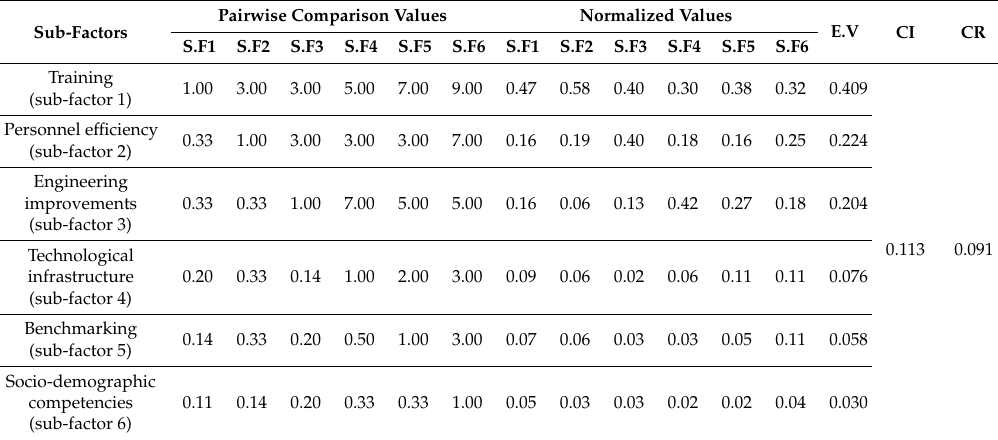
Table A3. The results for the pair-wise comparison of sub-factors with respect to factor 3. Pairwise Comparison Values Normalized Values Sub-Factors S.F1 S.F2 S.F3 S.F4 S.F5 S.F6 S.F1 S.F2 S.F3 S.F4 S.F5 S.F6 Training (sub-factor